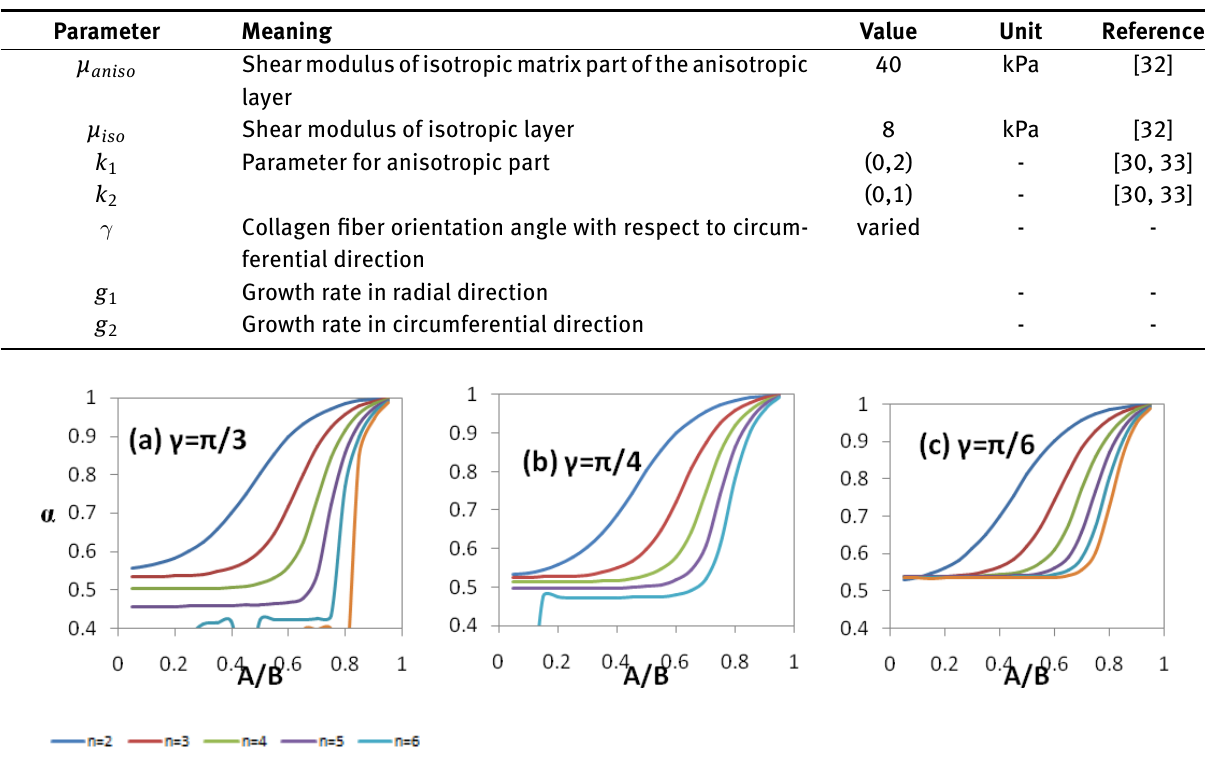
Figure 1: Critical strain at the inner radius α plotted against tube thickness for various buckling mode. Zero normal and shear stress bound- ary condition. µ =10kPa, k 1 =1, k 2 =0.2.